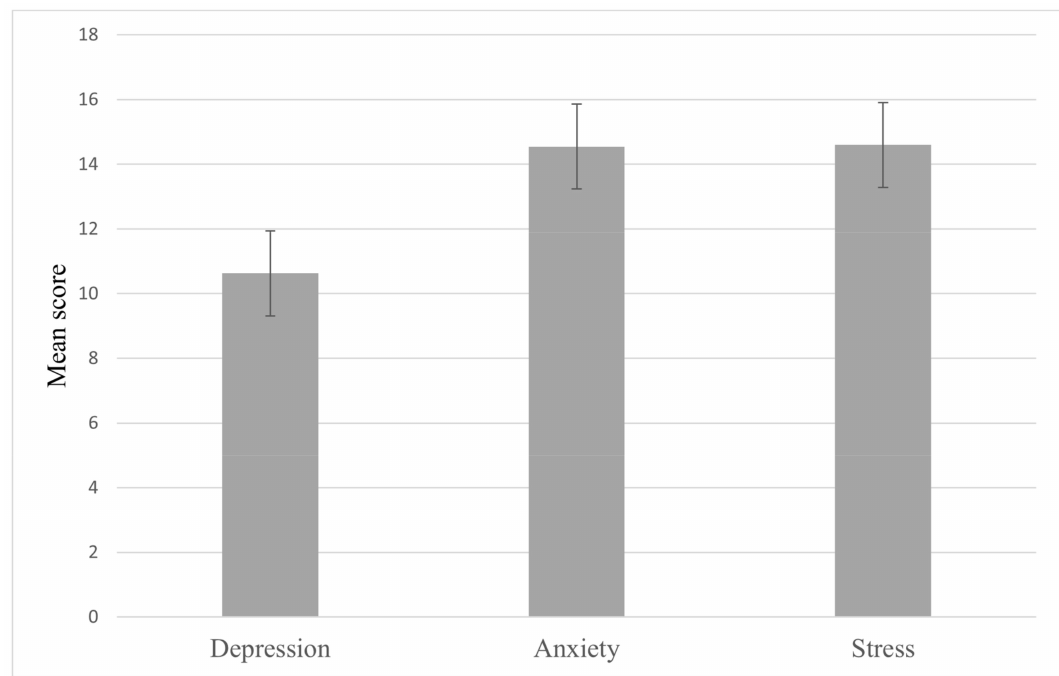
Figure 1. Means and standard deviations of the participants’ DASS-21 scale